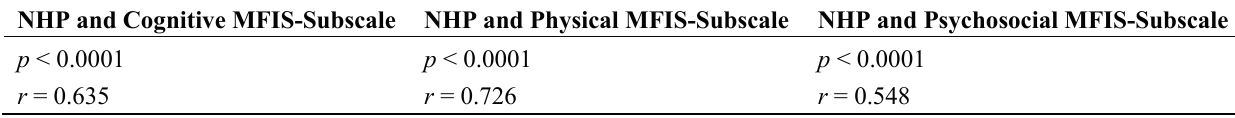
Table 7. Non-parametric correlations (Spearman–Rho) between NHP and the fatigue subscales. NHP and Cognitive MFIS-Subscale NHP and Physical MFIS-Subscale NHP and Psychosocial MFIS-Subscale p < 0.0001 p < 0.0001 p <